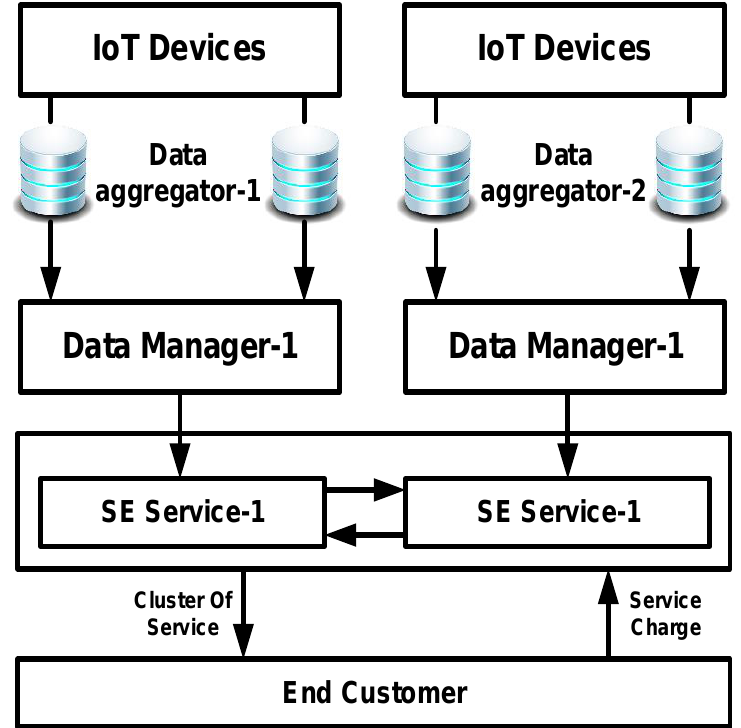
Figure 4. Optimised model for IoT-based SESaaS.